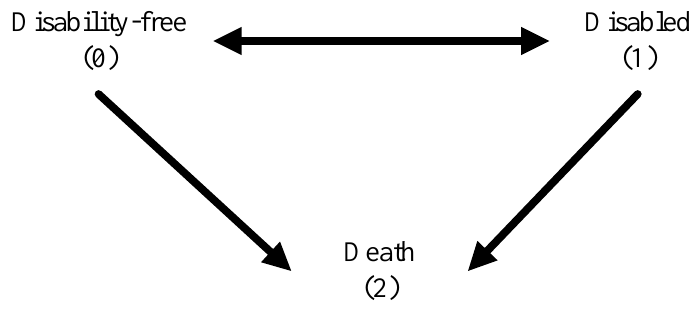
Figure 1. States and possible transitions across states.